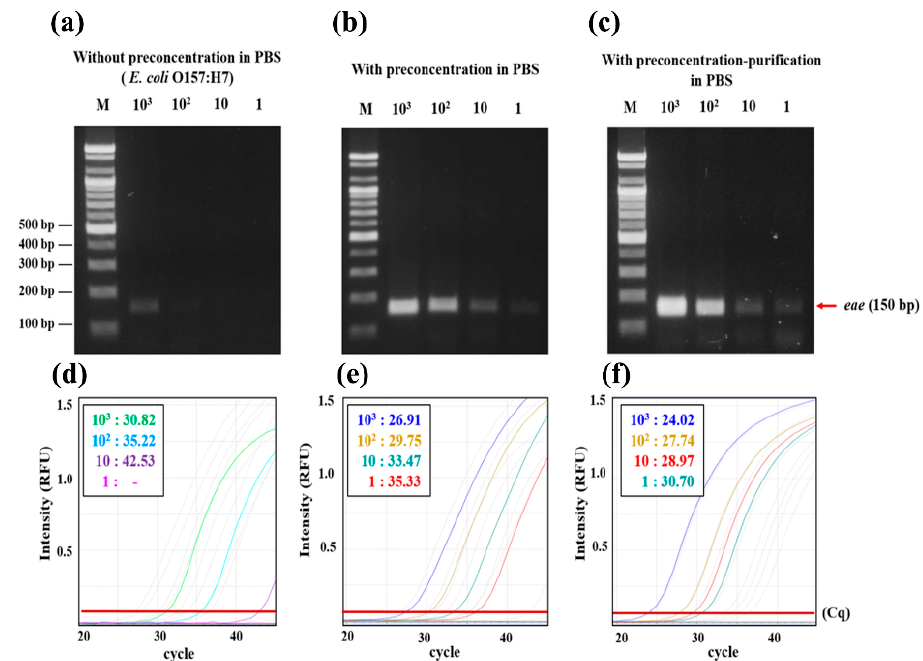
Figure 4. Confirmation of E. coli O157:H7 preconcentrating and DNA purifying efficiency using either PCR with gel electrophoresis and qPCR; ( a ) Gel electrophoresis of PCR products ( eae gene) from 10 mL PBS containing E. coli O157:H7 at different concentrations (1–10 3 CFU/mL) before preconcentration; ( b ) after preconcentration; ( c ) after bacterial preconcentration and DNA purification; ( d – f ) qPCR results of ( a – c ), respectively.